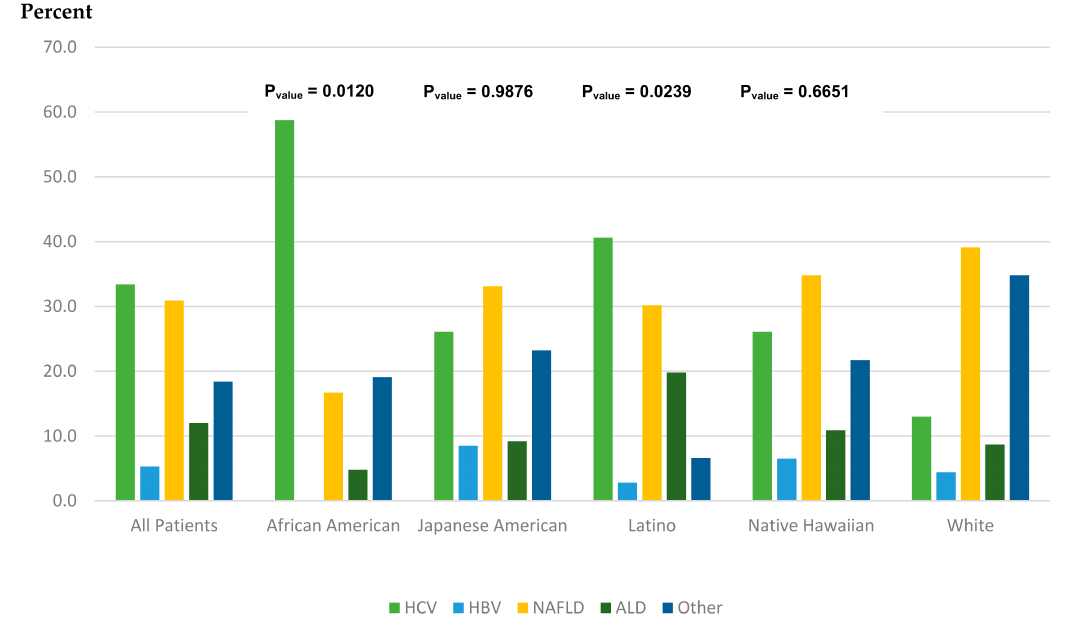
Figure 1. Underlying etiology overall and by racial/ethnic groups. p -value comparing each ethnic group to whites.